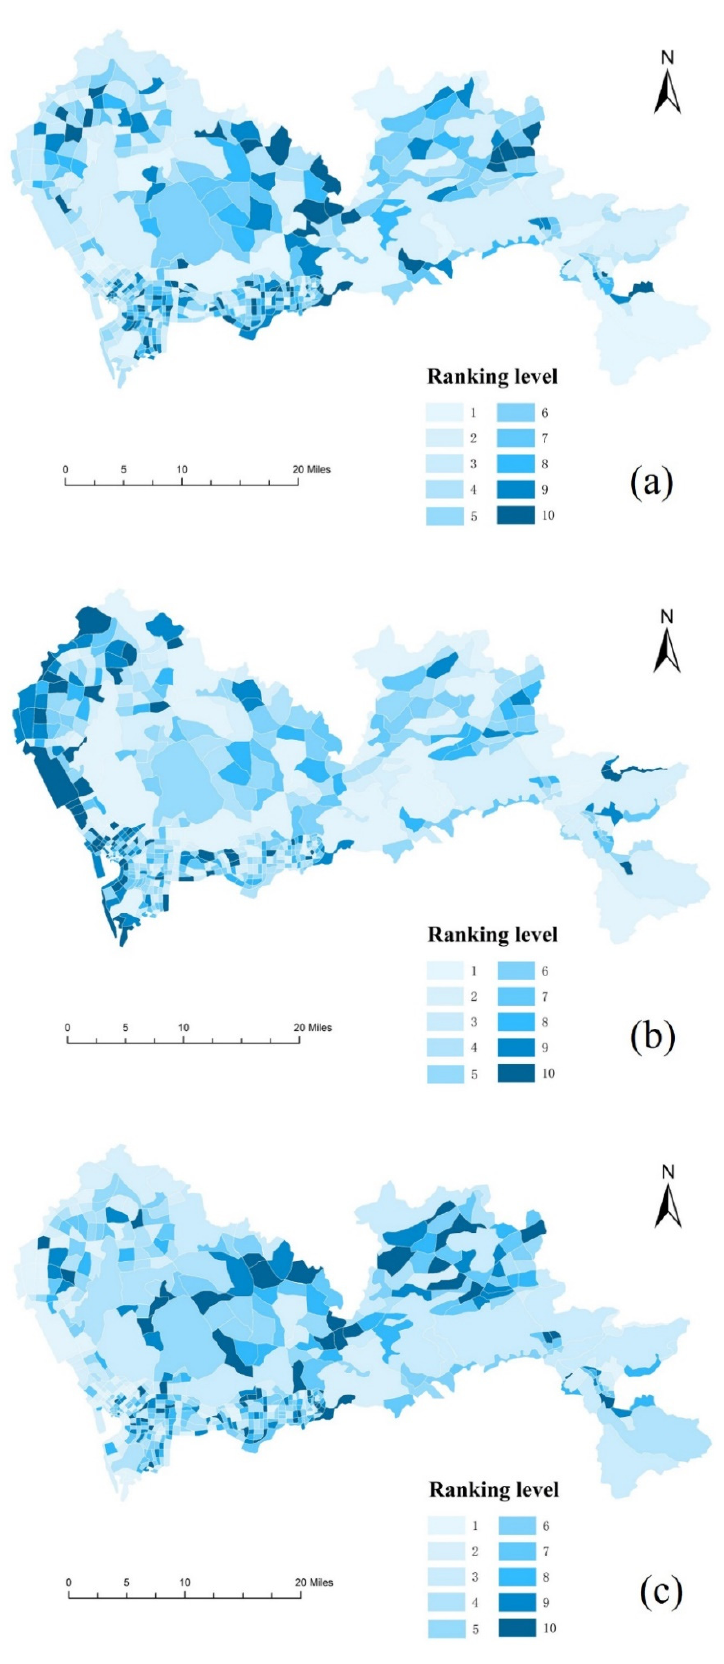
Figure 4. Proportion of LID layout under various scenarios: ( a ) Scenario 1; ( b ) Scenario 2; ( c ) Scenario 3.